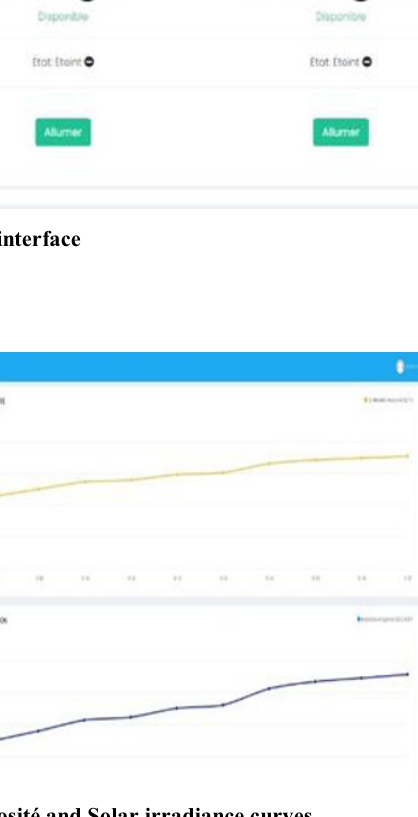
Fig. 6 Luminosité and Solar irradiance curves